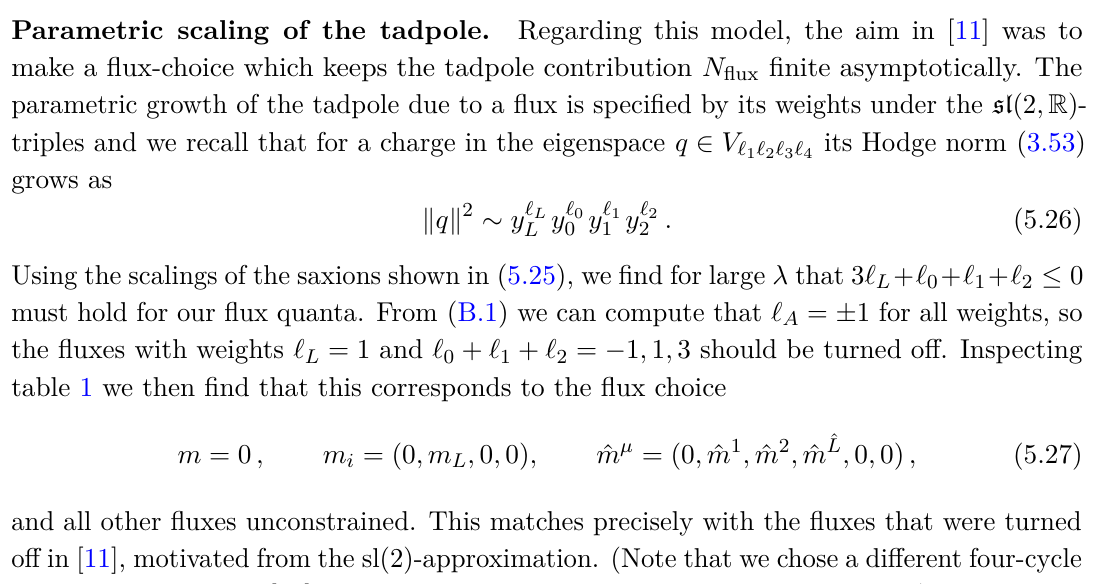
Parametric scaling of the